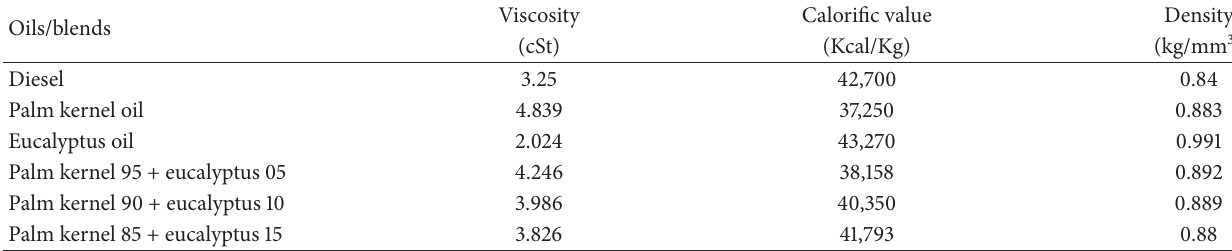
Table 2: Properties of experimental blends being done at ETA laboratories, Chennai, India.